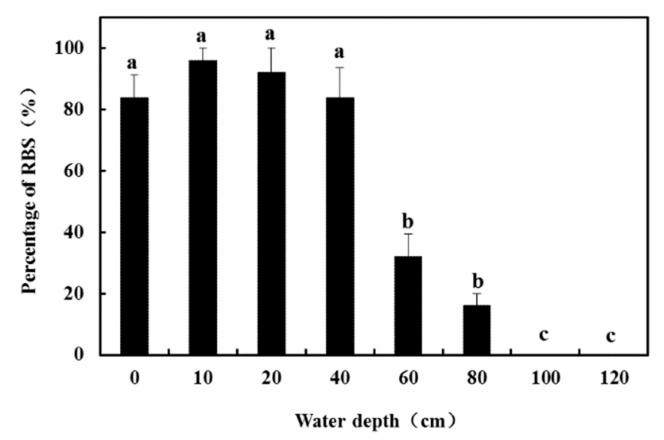
Figure 5. Responses of rhizome bud sprouting (RBS) percentage in Typha angustifolia to submergence depth. The bars indicate one standard error. Di ff erent letters indicate significant di ff erences between treatments ( P < 0.01).